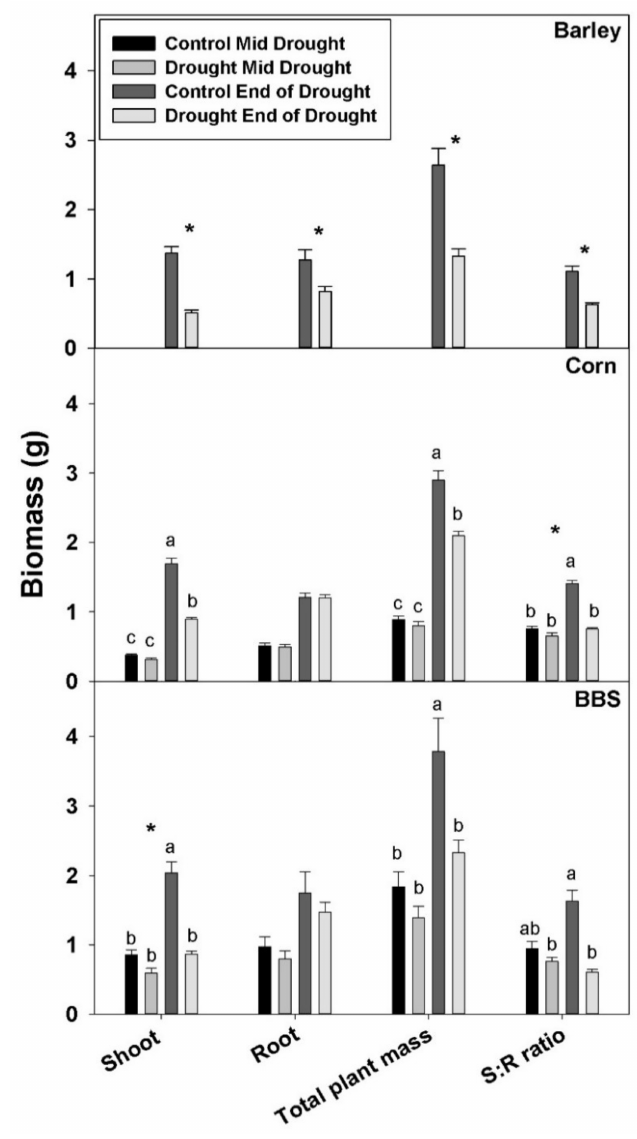
Figure 1. Effects of control vs. drought treatments on shoot, root, and total plant dry mass, and shoot:root (S:R) mass ratio in barley, corn, and big bluestem (BBS). Each bar represents mean + 1 SE (standard error). Within each panel, bars not sharing the same letters are significantly different. For each response variable, significant effects of drought (ANOVA), across both harvest in corn and big bluestem, are indicated with an asterisk (*). Note that only one harvest (end of drought) was conducted for barley because of its drought